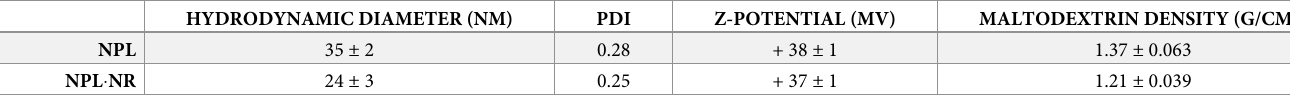
Table 1. Nanoparticles’ characterization.